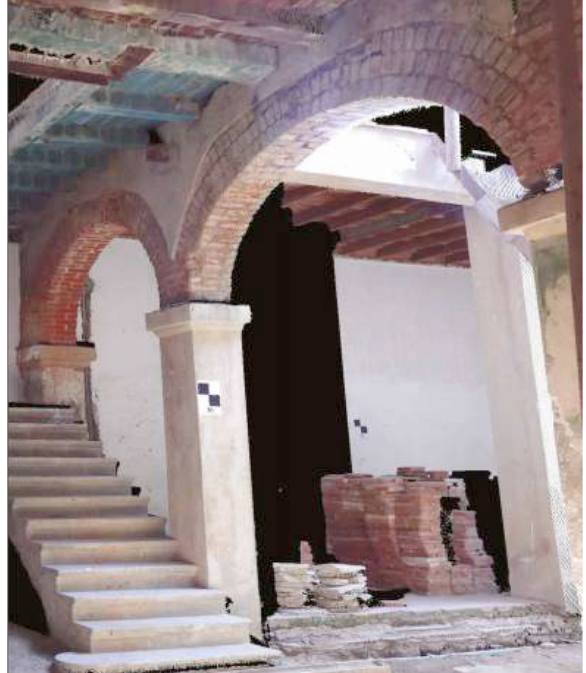
Figure 5. 3D model, point cloud, REDI centre,